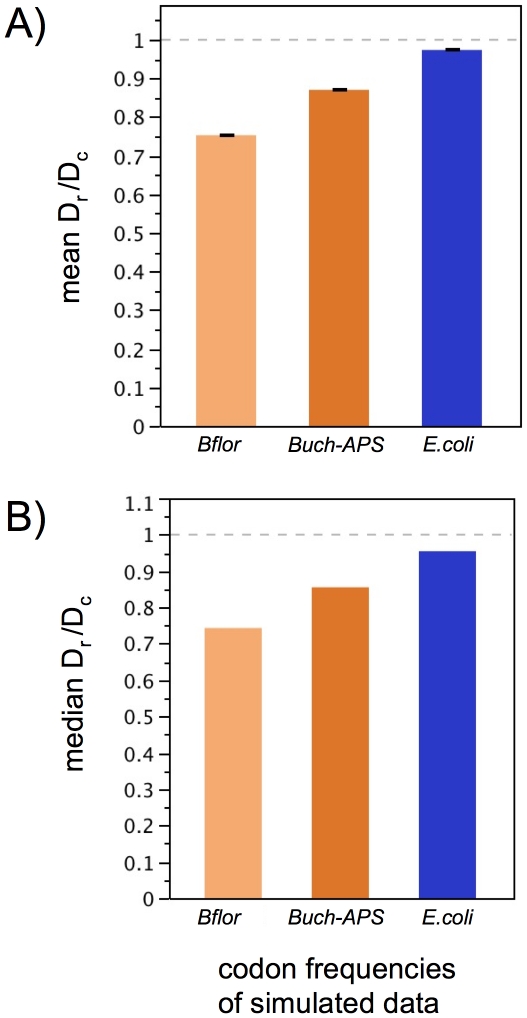
In simulated datasets, use of endosymbiont codon frequencies suppress Dr/Dc estimates.The chart represents a simplified version of Figure 5, pooling across other simulation parameters (kappa, t, and dN/dS) to illustrate the significant effect of codon frequencies. (a) Mean values (with bars indicating standard errors) and (b) median values of Dr/Dc are suppressed in datasets simulated under endosymbiont codon frequencies. Notably, these estimation biases occur in the opposite direction as the patterns observed in empirical genome comparisons, thereby making the inference elevated Dr/Dc in endosymbionts more conservative.